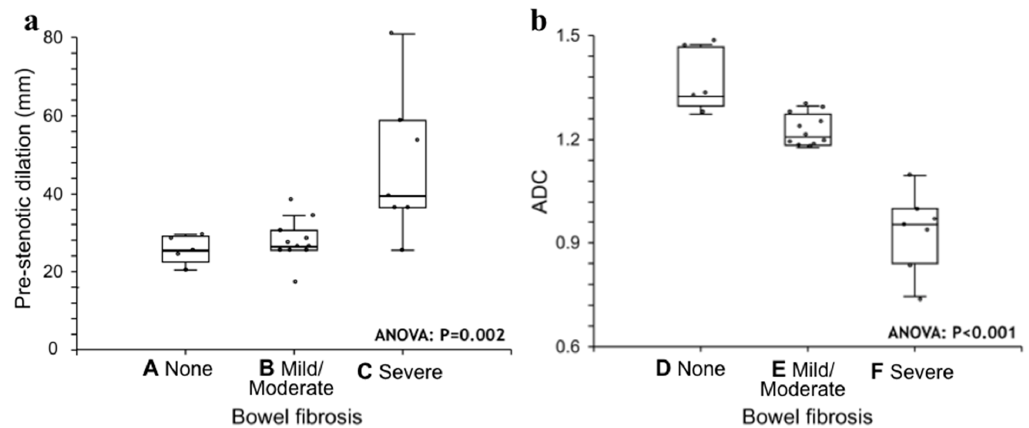
Figure 4. ( a , b ). Statistical analysis. Pre-stenotic upstream bowel dilatation ( panel a ) and ADC ( panel b ) sorted by fibrosis score. Medians are given with the interquartile range (IQR). ANOVA tests were performed. Bonferroni multiple comparison test: A ≠ C; B ≠ C; D ≠ E ≠ F. ADC = apparent diffusion coefficient.